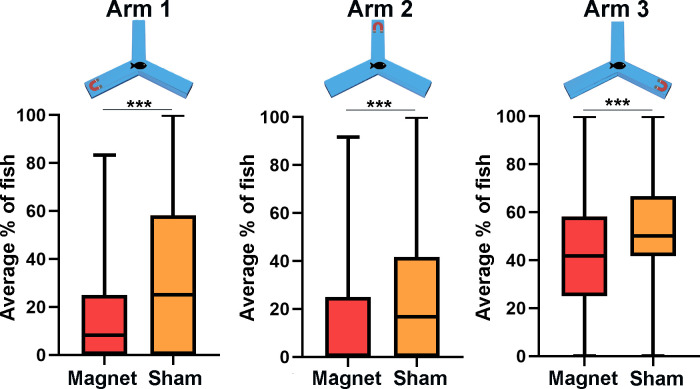
Changing location of stimulus results.The average percentage of fish school (n = 12) in each arm over five minutes. There is significantly less fish, on average, in the arm when magnet is present compared to when sham in present in the same arm (*** p < .0005 Mann-Whitney U Test). This is a Spear Box Plot with the box showing 25% to 75% interquartile range and median represented as a black line, whiskers show minimum and maximum values. Arm 1 Magnet: median = 8.33%, IQR = 25%; Arm 1 Sham: median = 25%, IQR = 58.77%; Arm 2 Magnet: median = 0%, IQR = 25%; Arm 2 Sham: median = 16.67%, IQR = 41.67%; Arm 3 Magnet: median = 41.67%, IQR = 33.33%; Arm 3 Sham: median = 50%, IQR = 25%.